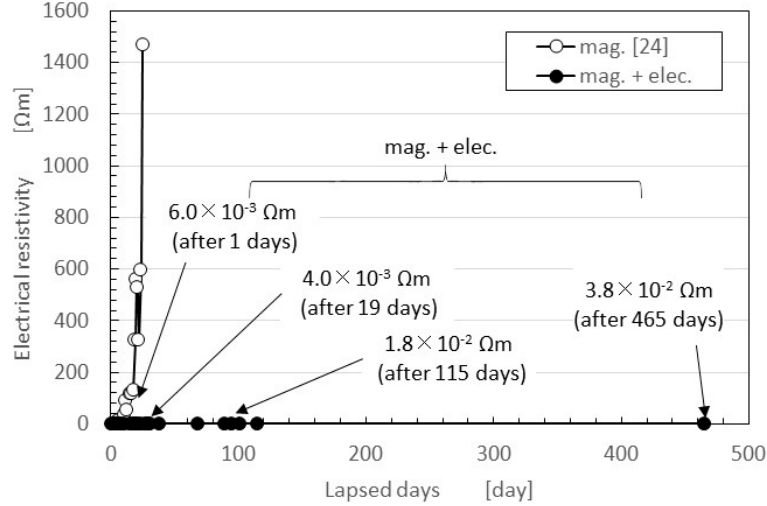
Figure 6. The secular changes in electric resistance between the electrodes opposing each other with no normal force applied to the vulcanized MCF rubber utilizing NR-latex.